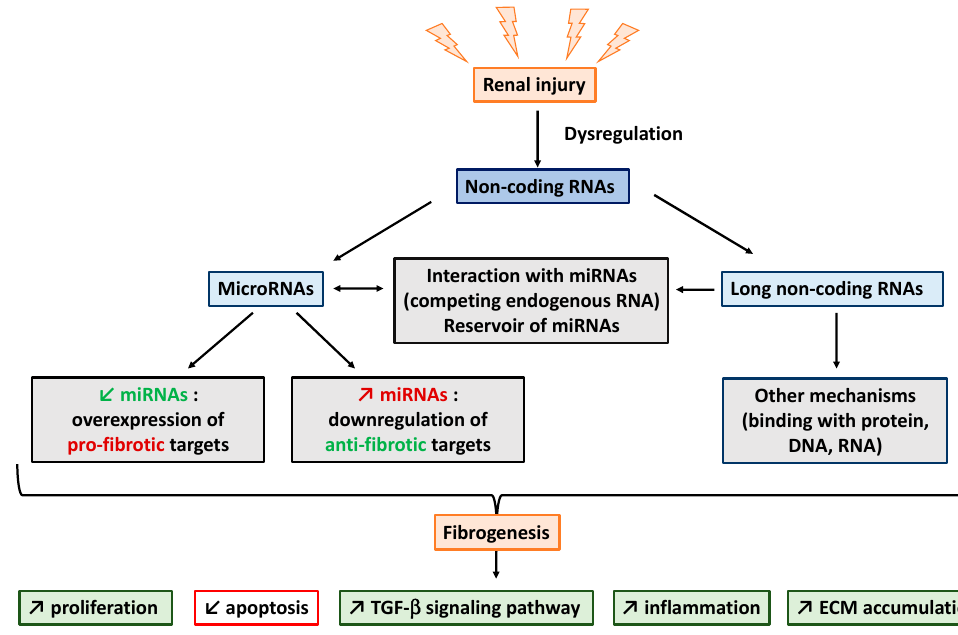
Figure 3. General mechanisms of non-coding RNAs involved in kidney fibrosis.